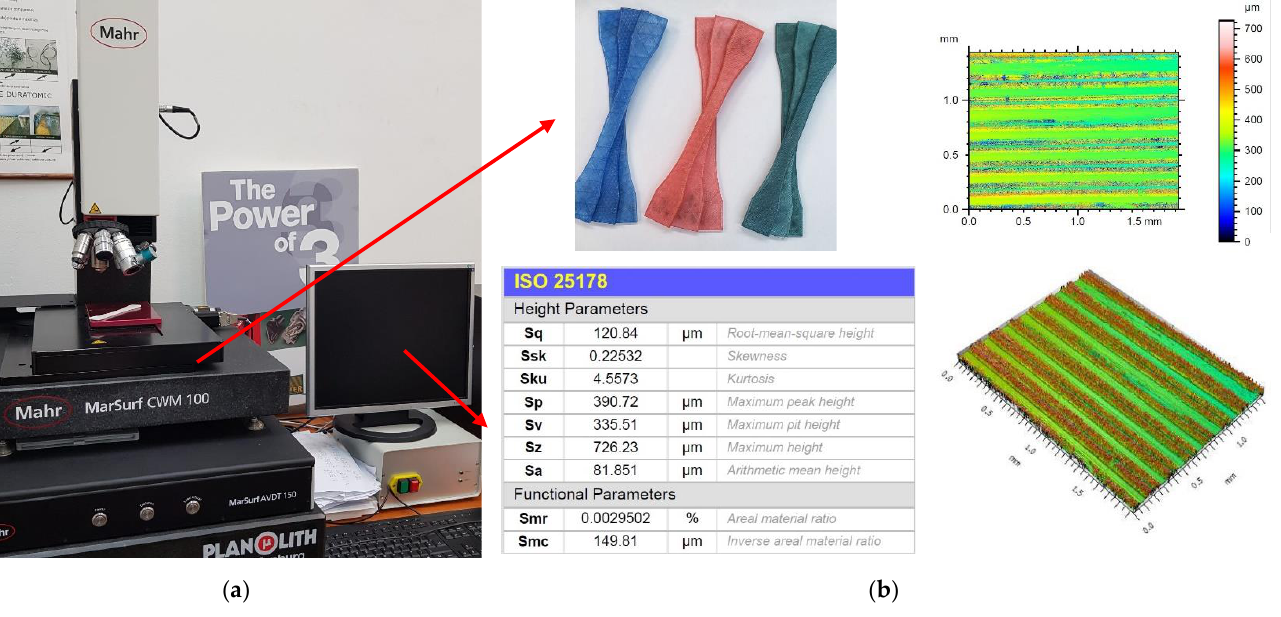
Figure 11. Surface roughness measurement: ( a ) Mahr MarSurf CWM 100; ( b ) tested specimens and value recording.